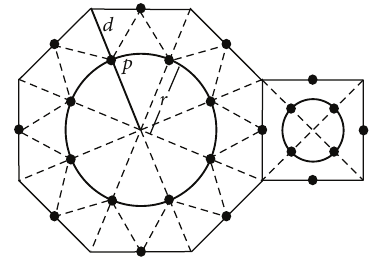
Figure 16: Side on segment control diagram (Type